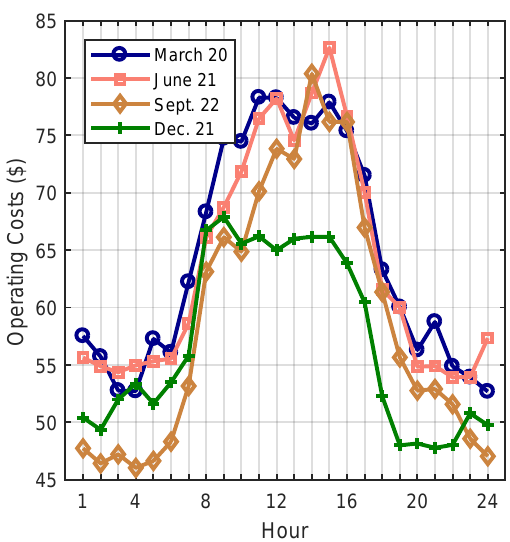
Figure 8. Operating costs of the DES of the four example days.